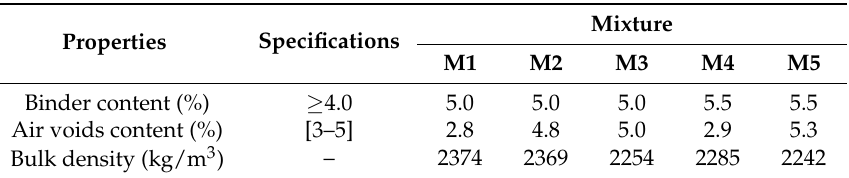
Table 4. Volumetric characteristics of the studied mixtures.